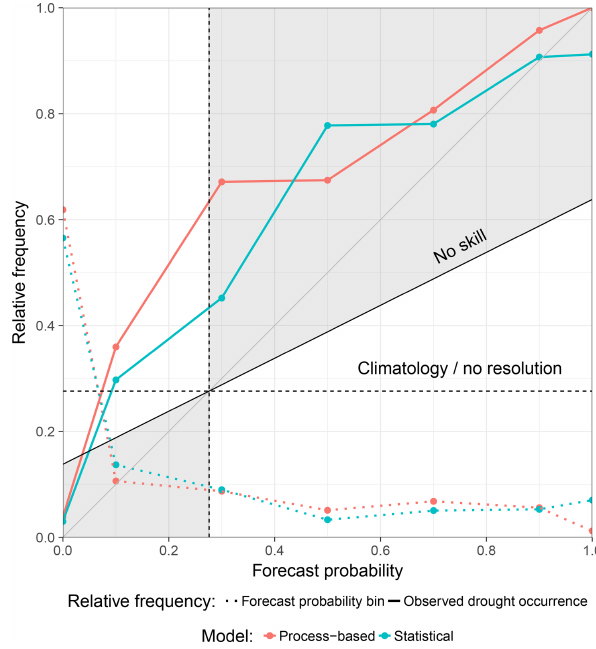
Figure 5. Attribute plot of drought hindcasts aggregated over the whole study area. Values within the gray region contribute posi- tively to the Brier skill score (BSS). For details on the interpretation of the plot see